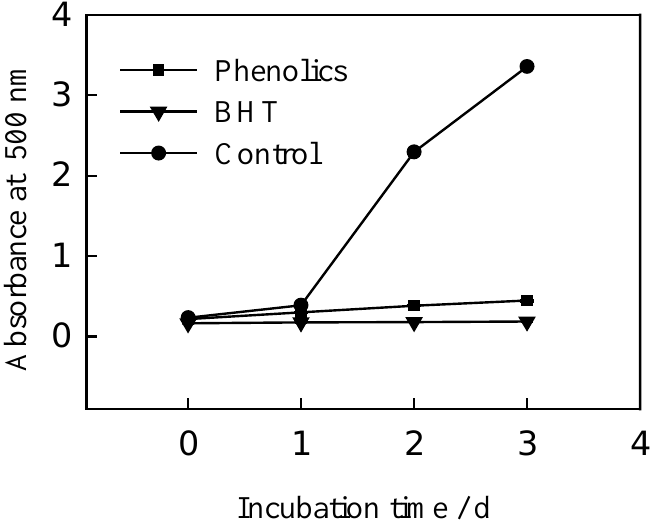
Figure 2. Antioxidant activity of phenolics from litchi pericarp tissues, measured by the ferric thiocyanate method.